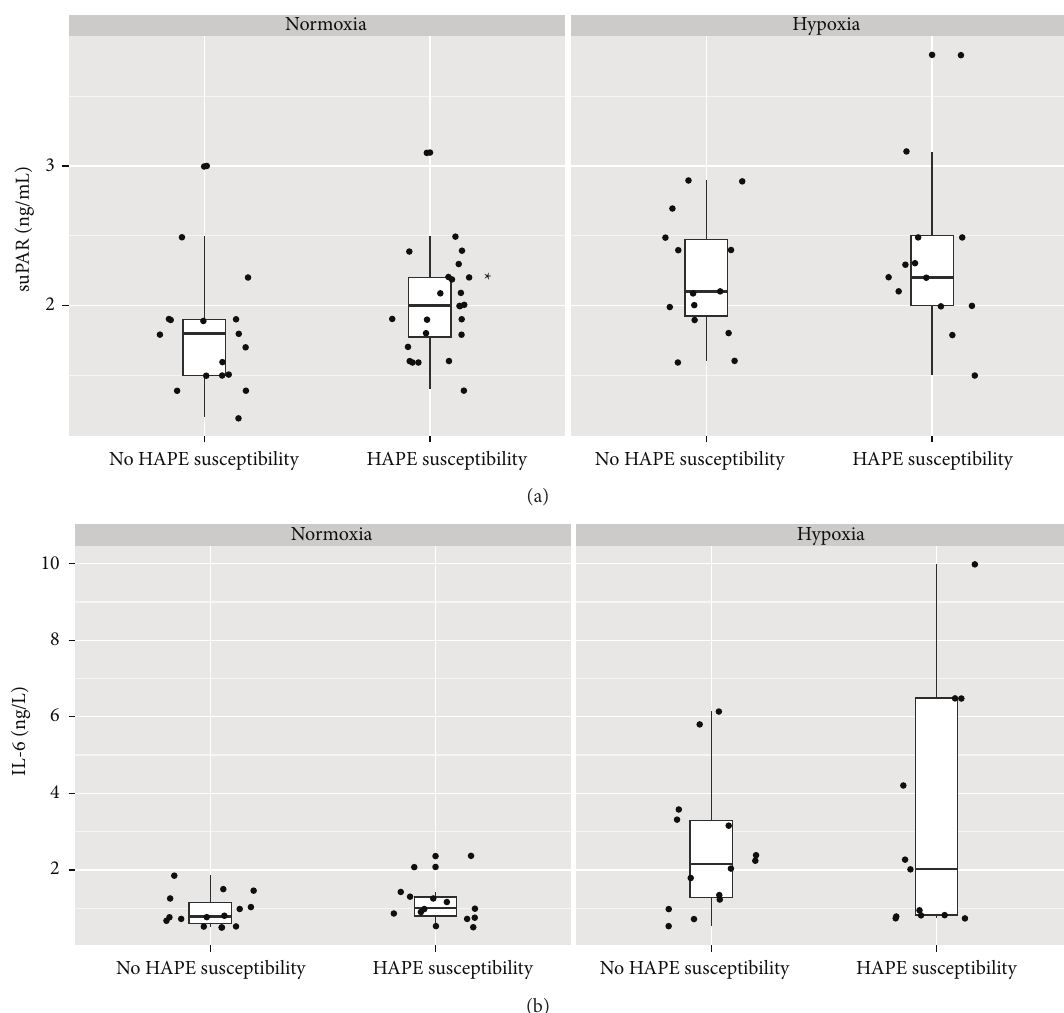
Figure 2: suPAR (a) and IL-6 (b) plasma concentrations in normoxia and hypoxia, in HAPE-susceptible versus non-HAPE-susceptible persons. ( ∗ ) denotes a difference in HAPE versus HAPE-susceptible subjects ( 𝑝 < 0.05 ). Boxplots represent median, interquartile range, and range. Horizontal scattering is applied to the individual data points in order to avoid superimposition. HAPE: high altitude pulmonary edema, suPAR: soluble urokinase-type plasminogen activator receptor, and IL-6: interleukin 6.